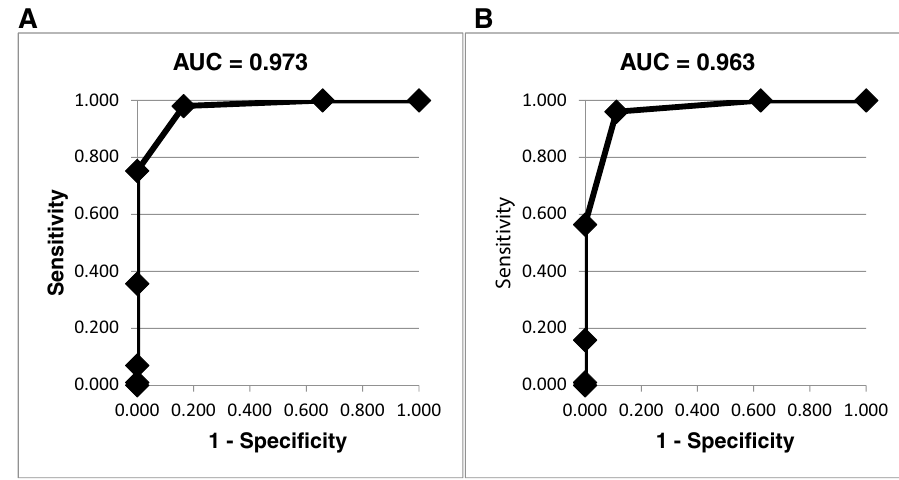
Fig. 1 ROC curves of the mul- tivariate model using the entire population. (A) ROC curve of the multivariate model using 6 variables. (B) ROC curve of the multivariate model using 5 variables